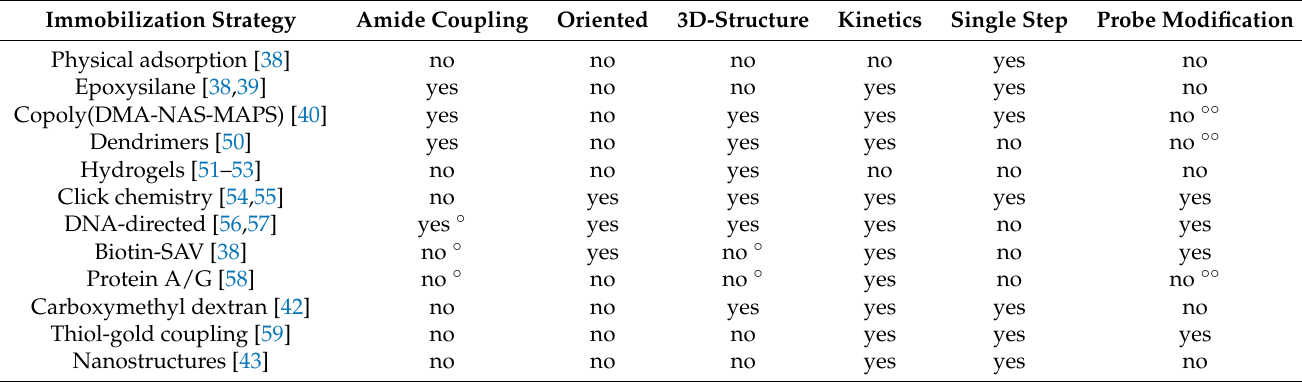
Table 1. Main characteristics, capabilities and limits of the immobilization methods for label-free bioassays discussed here. Immobilization Strategy Amide Coupling Oriented 3D-Structure Kinetics Single Step Probe